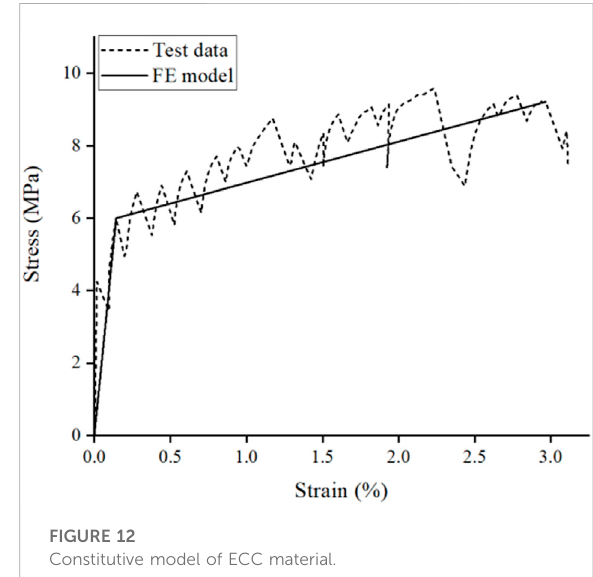
Constitutive model of ECC material.